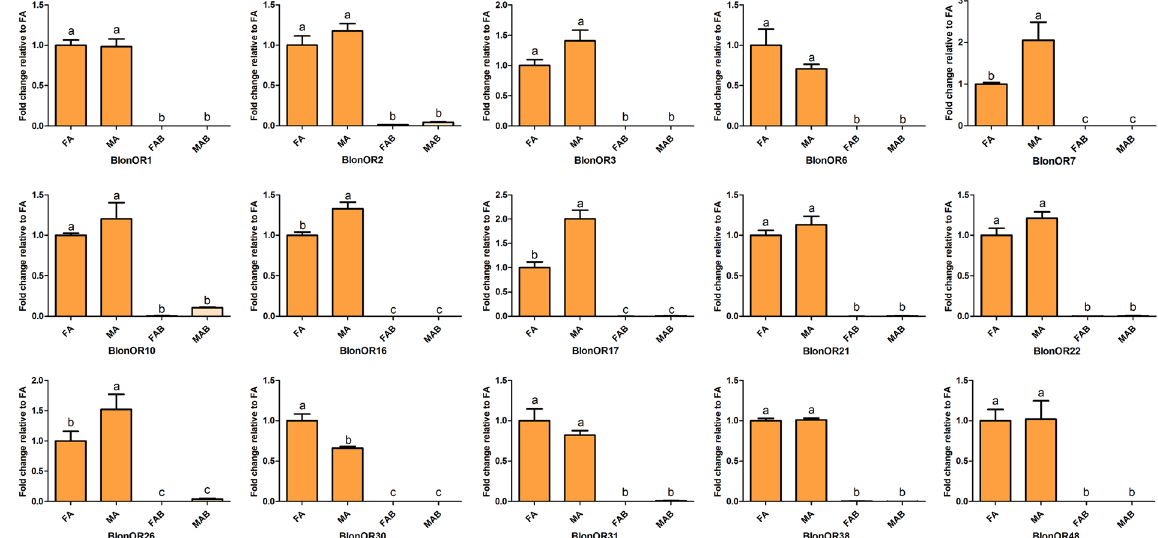
Figure 2. Relative expression levels of the top 15 overexpressed ORs using qPCR. FA, female antennae; MA, male antennae; FAB, female terminal abdomens; MAB, male terminal abdomens. The relative expression level is indicated as mean ± SE (N = 3). Different letters indicate significant differences between tissues (P < 0.05, ANOVA, LSD).